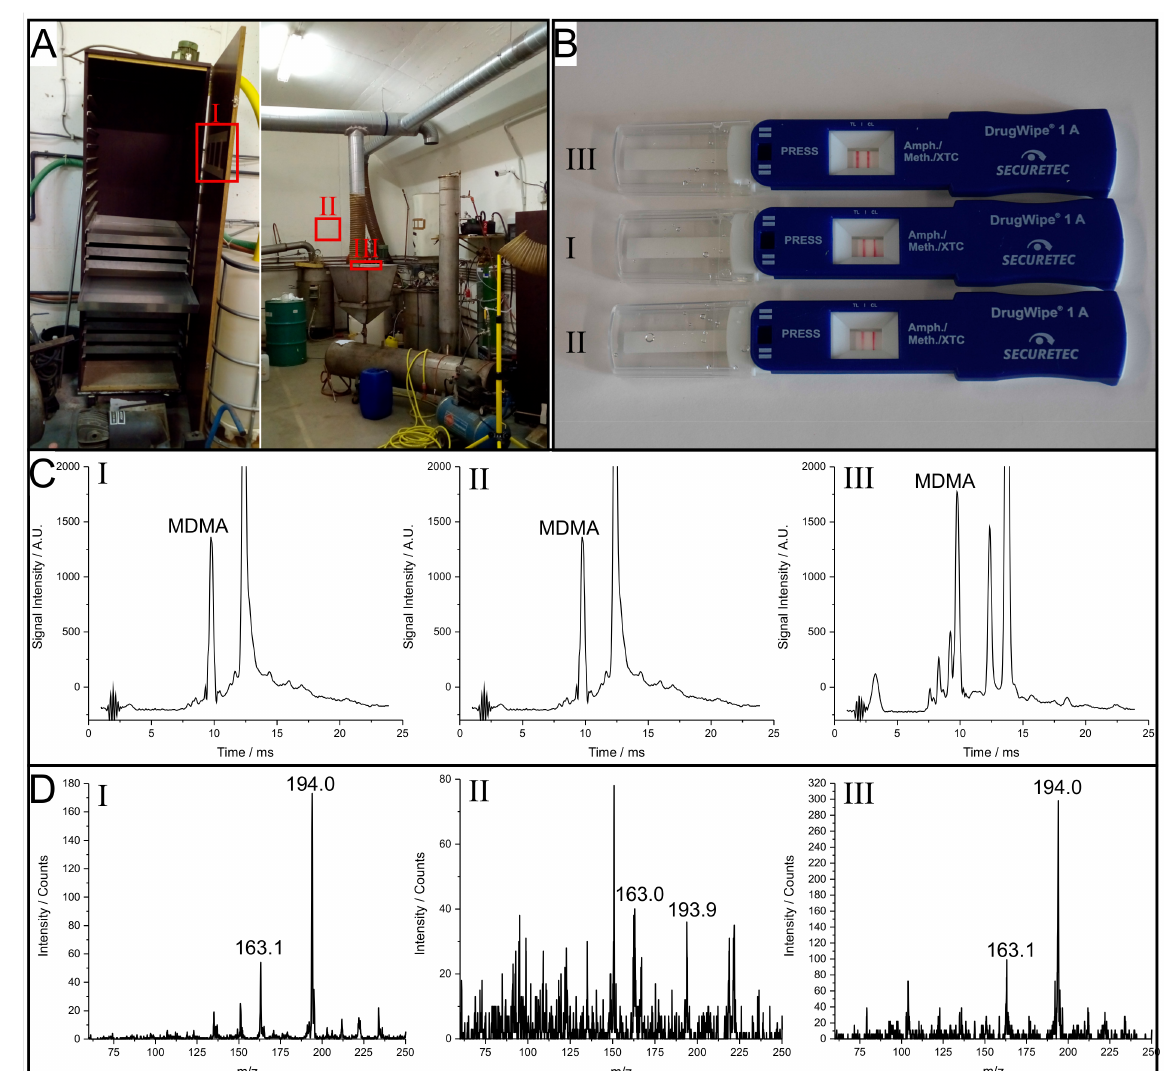
Figure 2. ( A ) Sampled areas are (left to right): drying cabinet, wall and Büchner funnel, all marked with red rectangles. ( B ) Positive IDTs of the sample areas (indicated by two bars) at ( A ). Results are (from up to down): Büchner funnel, drying cabinet and wall. ( C ) IMS measurements of the three sampling sports. IMS plasmagrams are in the following order (left to right): drying cabinet, wall, and Büchner funnel. MDMA signal at around 9.8 ms. ( D ) Positive CI mass spectra of the three sampling spots. Spectra are in the following order (left to right): drying cabinet, wall, and Büchner funnel. The signal of 194 m/z is related to the molecular ion peak [M + H] and 163 m/z corresponds to